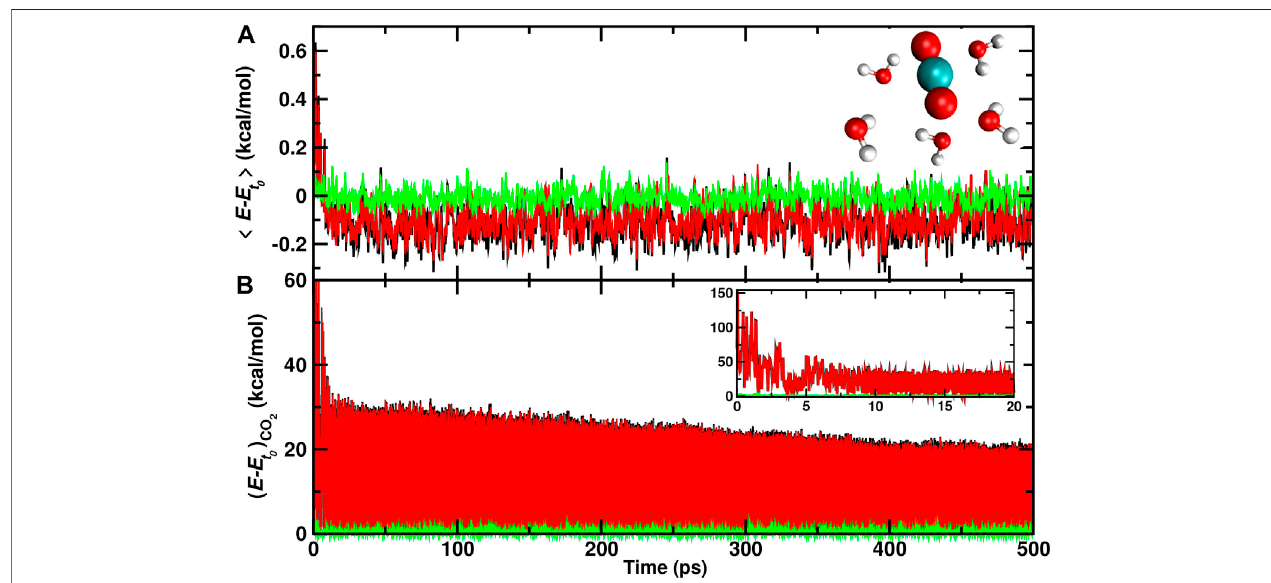
FIGURE 6 | Average total (black), internal (red), and translational (green) energies for 5 water molecules (A) closest to the CO 2 , and the CO 2 molecule (B) formed fromarecombinationtrajectoryontheASWsurface.Thetimeofreactionisshiftedto t (cid:2) 0andde fi nedbythe fi rstinstanceatwhich r C − O energy redistribution from the relaxing CO 2 molecule to internal and translational degrees of freedom of the ASW occurs on the 10 ps time scale with slow gradual relaxation on the ∼ 100 ps to ns time scale. On the 500 ps time scale the 5 water molecules slightly cool compared with the kinetic energy before recombination.